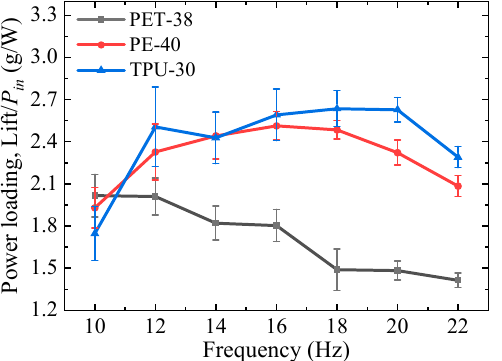
Figure 8. Power loading versus frequency for different wings.